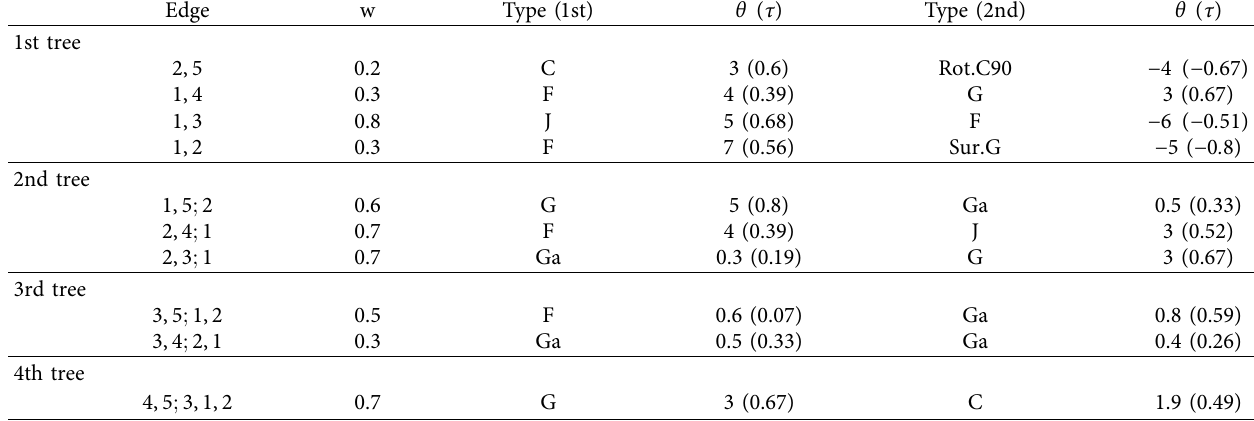
Table 1: Summary of the two-component full R -vine copula mixture model.